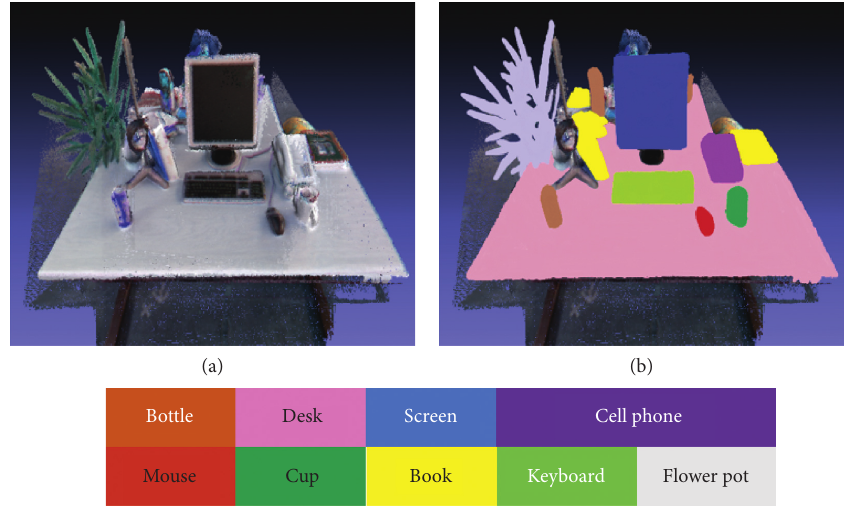
Figure 13: 3D map (a) and 3D semantic map